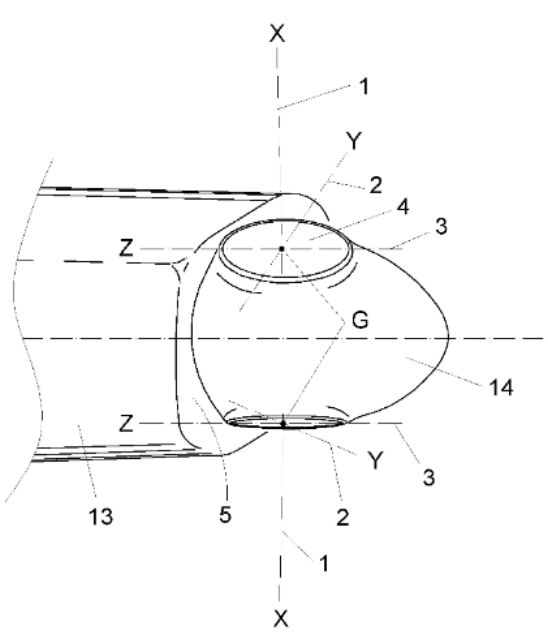
Figure 9. Schema of the reference system for the measuring procedure.